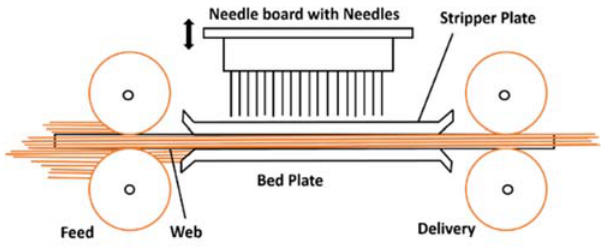
Figure 2. Needlepunching process to form non-woven fabric from fibrous web.